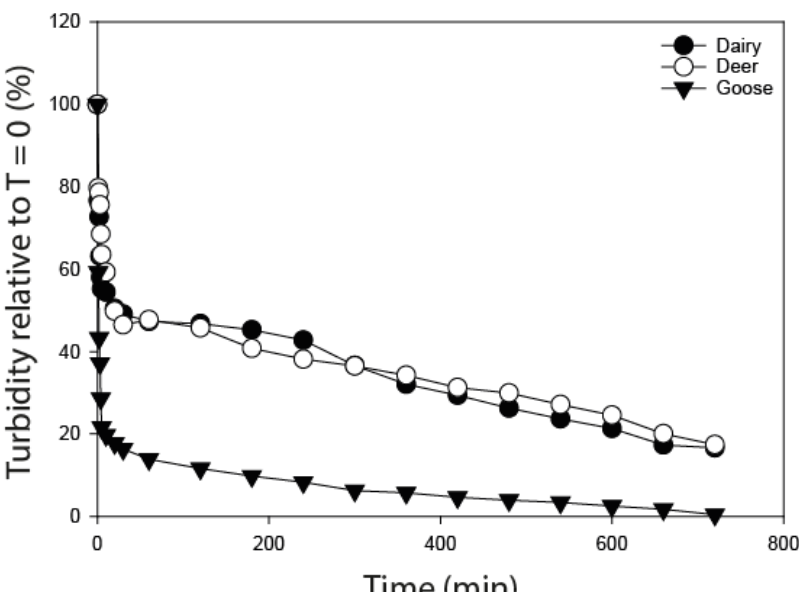
Figure 2. Sedimentation rate as measured by percentage change in turbidity over time. Table 2. Turbidity (Nephelometric Turbidity Units) values over time for each of the faecal treat- ments.